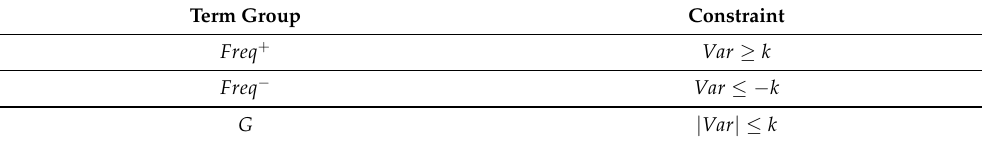
Table 4. Common term classification constraints.